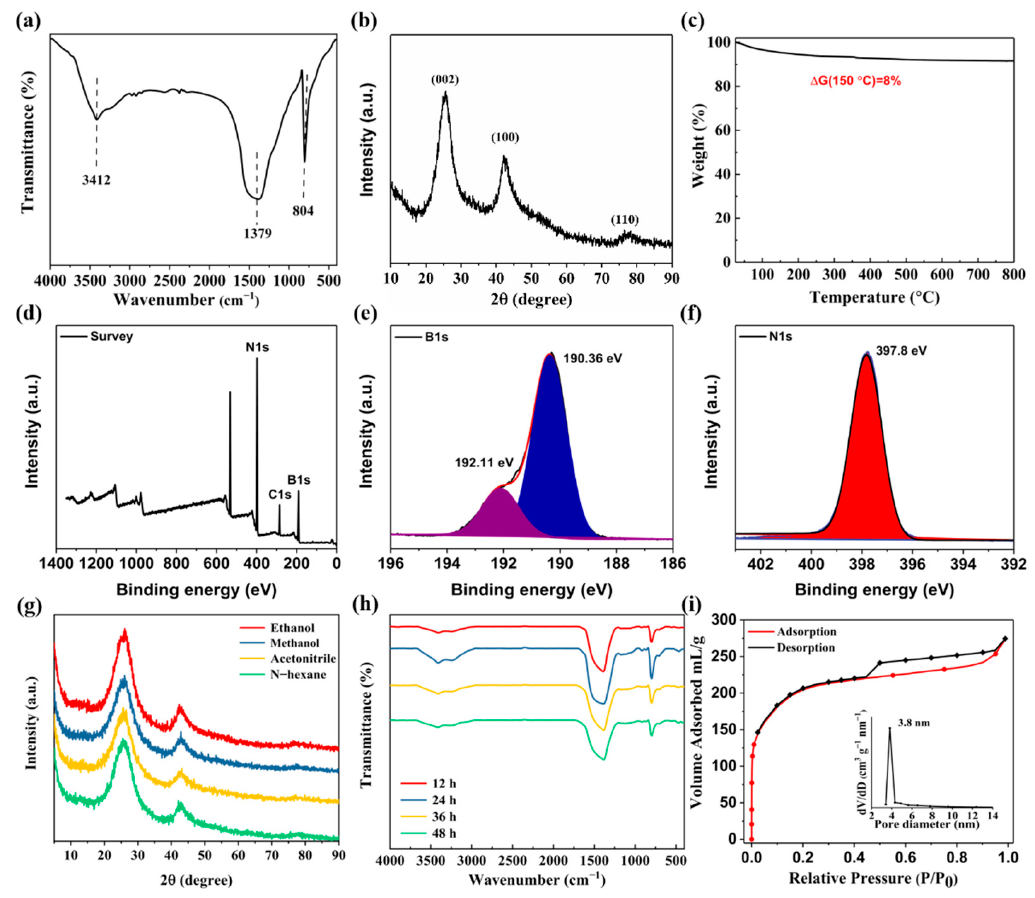
Figure 3. The XRD pattern ( a ), FT-IR spectra ( b ), TGA curve ( c ) of h-BN, the XPS spectrum of h-BN ( d ), the B1s ( e ) and N1s ( f ) spectra of h-BN, the XRD patterns of h-BN after soaking in the different organic solvents for 12 h ( g ); the FT-IR patterns of h-BN after soaking for 12 h, 24 h, 36 h and 48 h in the water ( h ); and the nitrogen-adsorption isotherms and pore diameter distribution of h-BN ( i ).